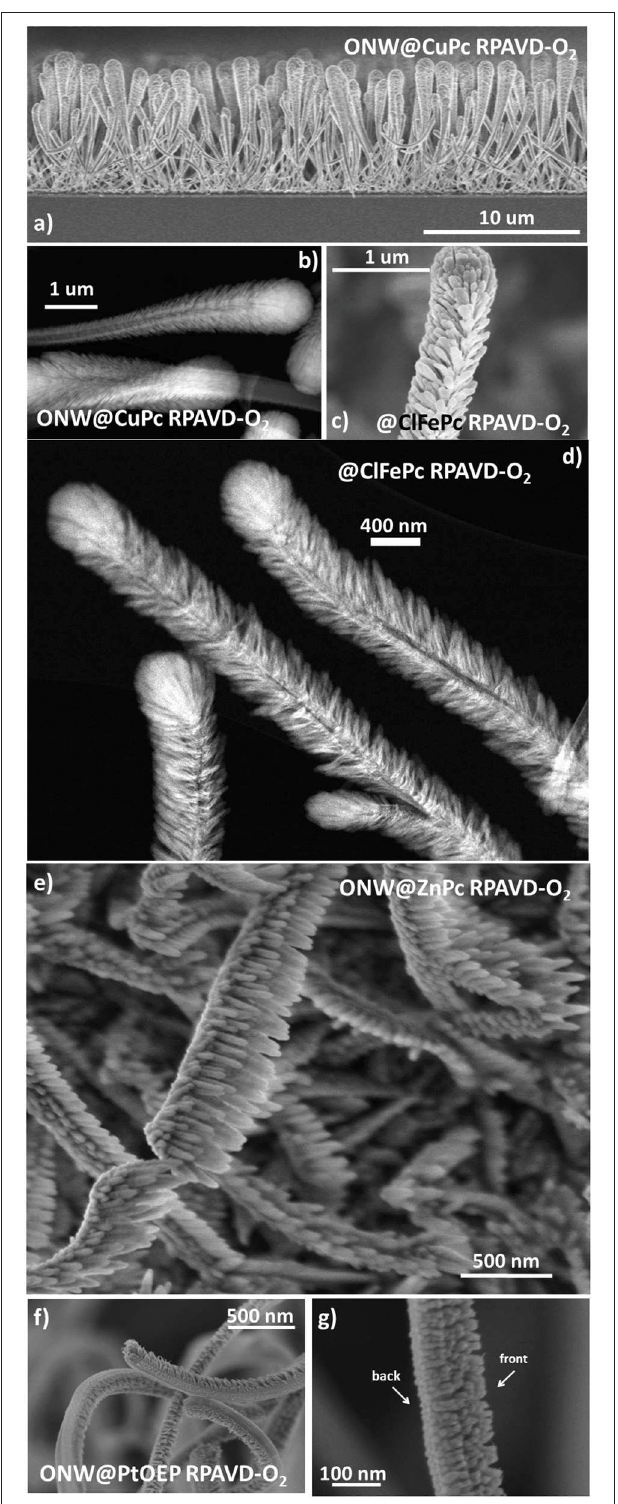
FIGURE 6 | SEM (a,c,e–g) and HAADF-STEM (b,d) micrographs of core@shell nanowires formed by ONWs of H 2 Pc (a,b) and MePTCDI (e,f) . The micrograph in (d) shows the formation of ClFePc nanotubes after removing the H 2 Pc cores.